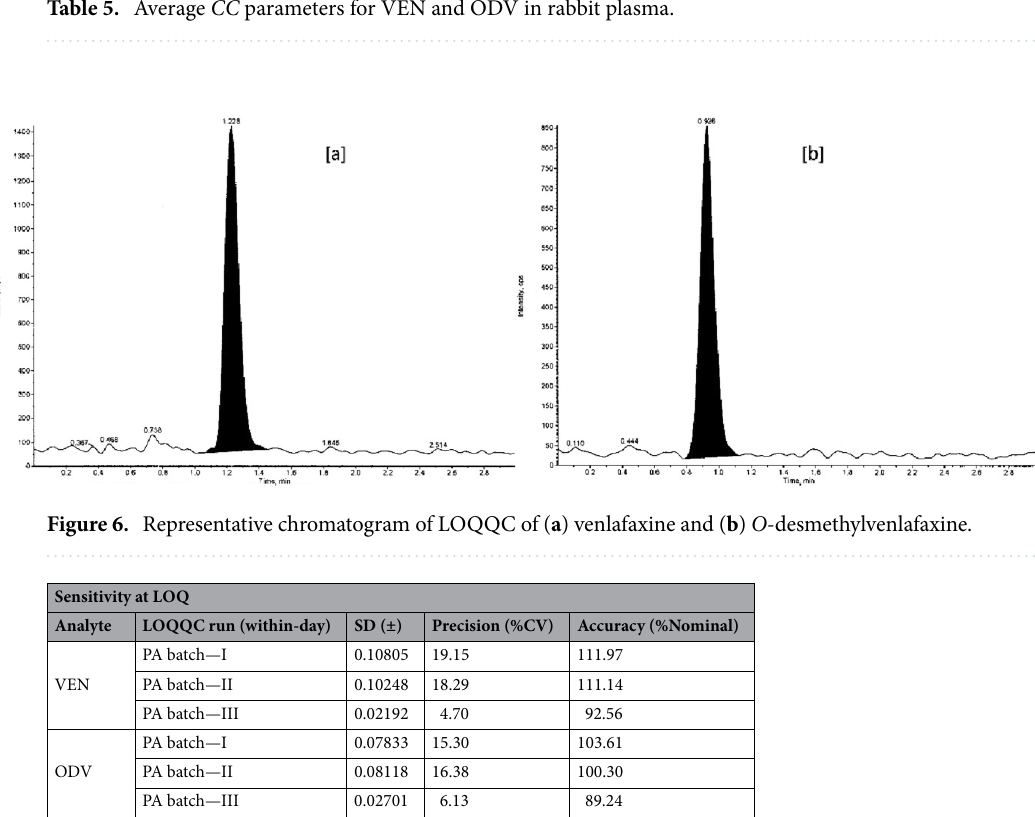
Table 6. Sensitivity at LOQ for each analyte in rabbit